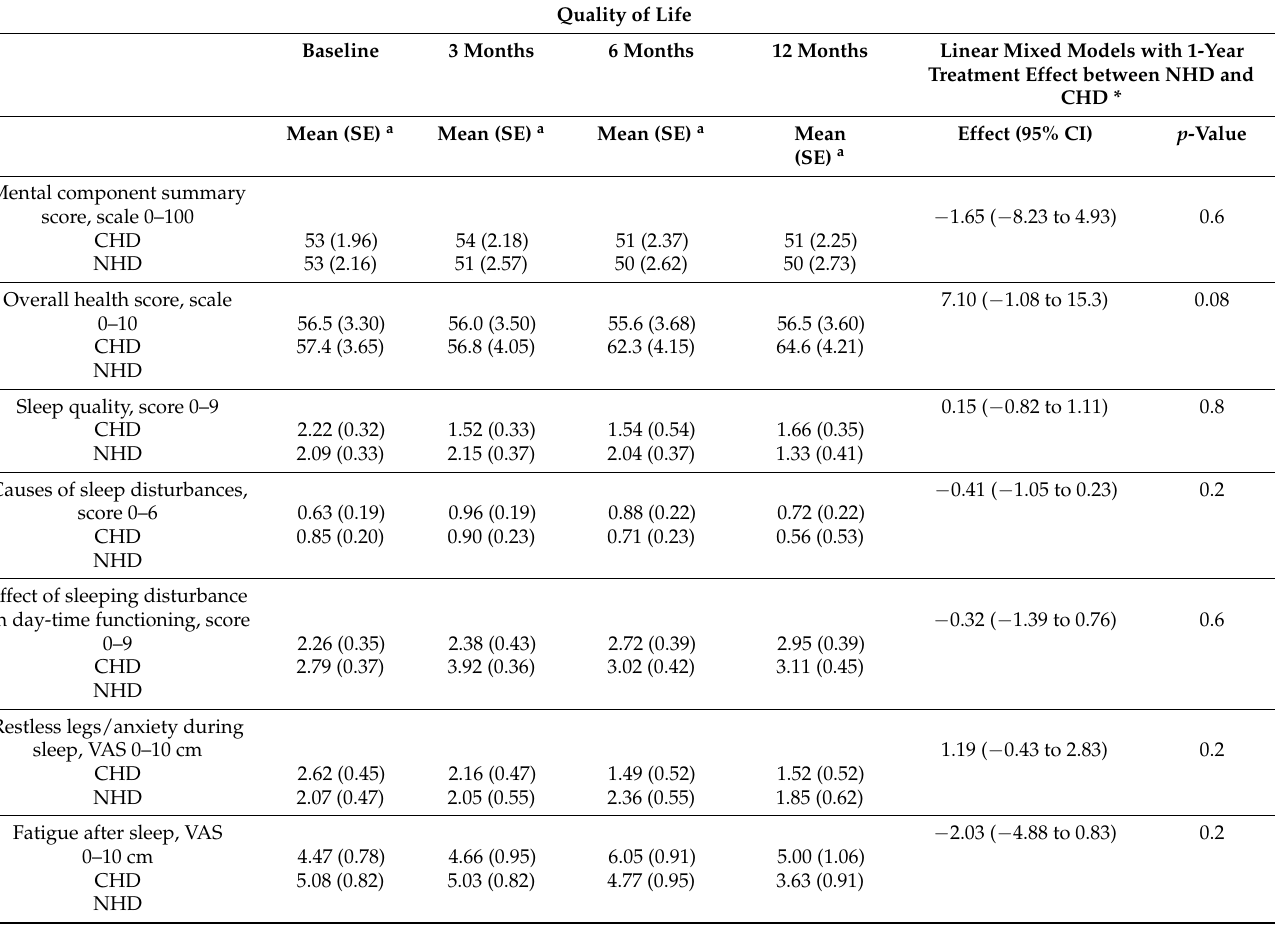
Quality of life over 1 year in nocturnal hemodialysis patients and conventional hemodialysis